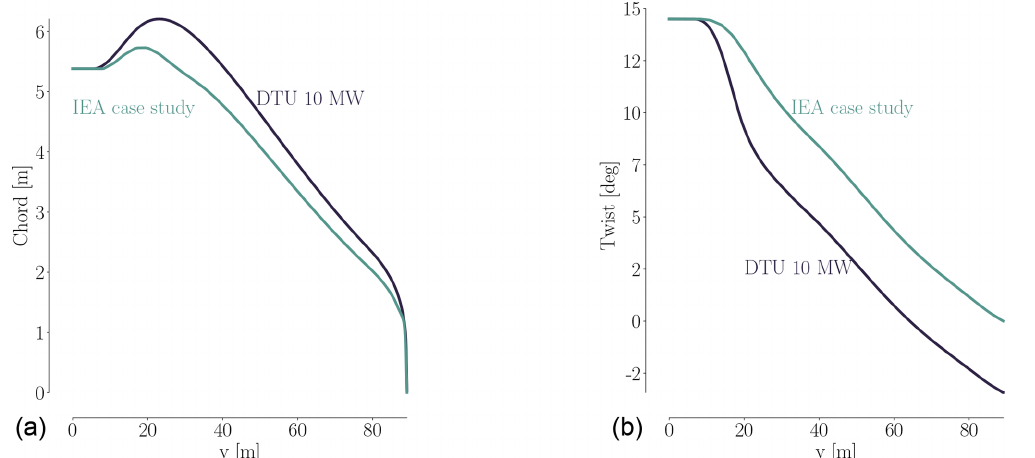
Figure 2. Comparison of chord (a) and twist (b) for the DTU 10MW RWT and the perturbed design used as the starting point for the IEA optimization case study. Both the chord and twist are reduced. The baseline blade design is based on the FFA-W3 airfoil family with relative thicknesses in the range of [ 24% , 36% ] .